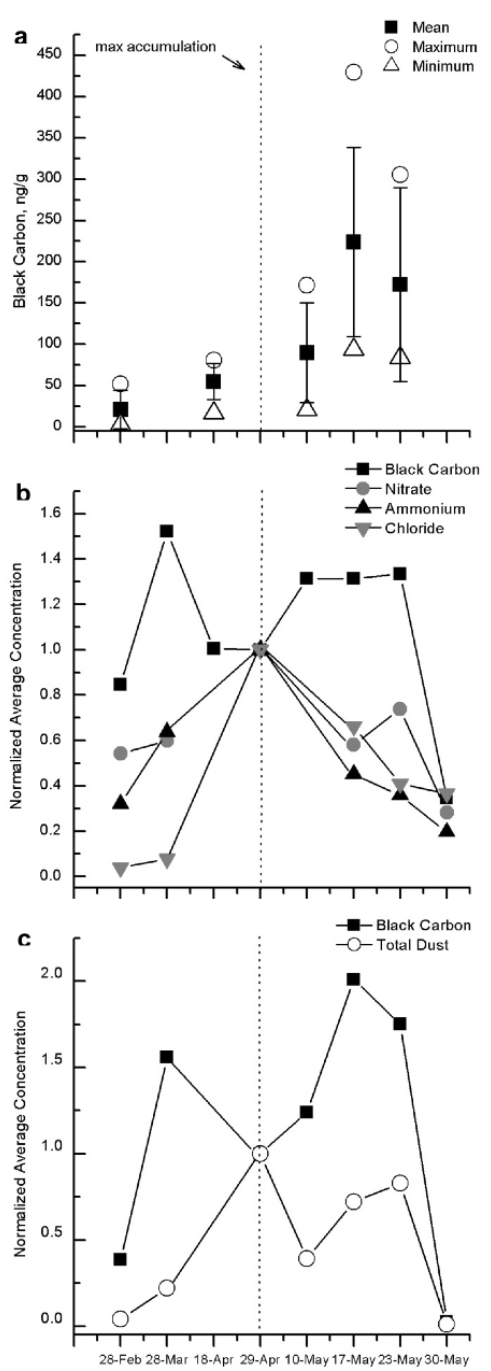
Fig. 2. (a) rBC concentration (ngg − 1 ) in surface (top ∼ 2cm) snow samples, n max = 6; (b) snow pit concentrations normalized to those at maximum accumulation when the snowpack became isothermal and melt water started to drain; (c) rBC and dust concentrations in the top 30cm of snowpack normalized to those at maximum accumulation.